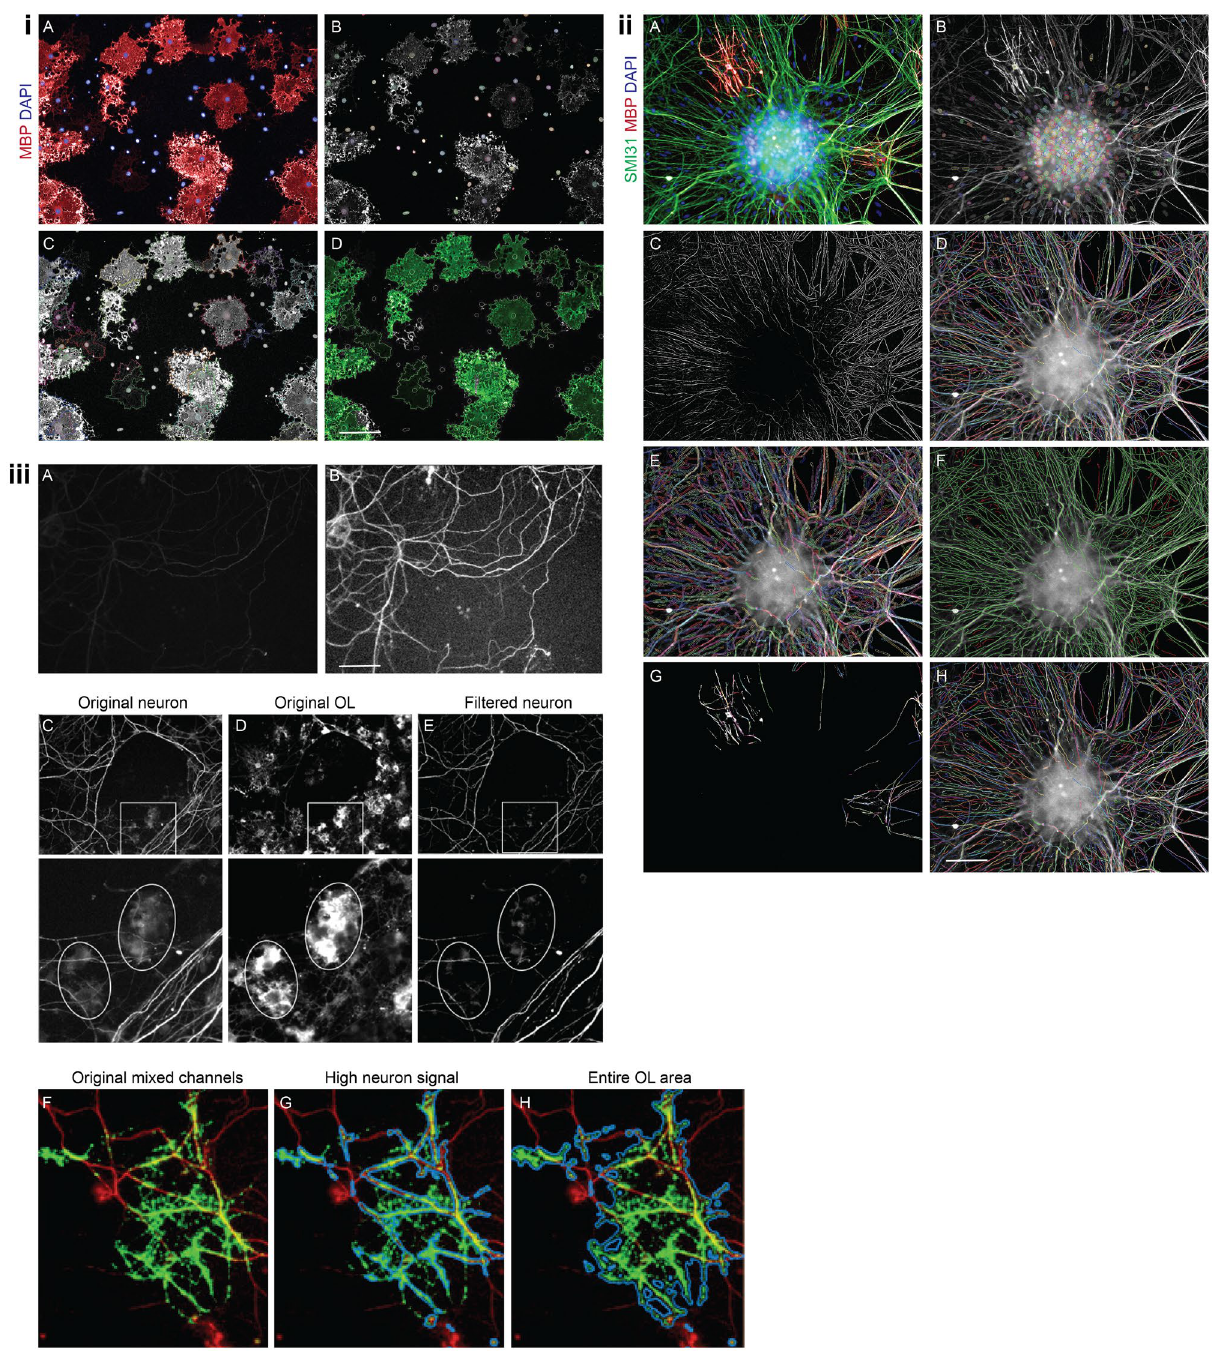
Figure 1. Representative images of OPC differentiation analysis sequence ( iA ) input data in step1, ( iB ) nuclei detection in step 2, ( iC ) cell cytoplasm detection in step 3, ( iD ) MBP+ population after definition of filter and characteristics properties in step 6. Representative images of length of myelinated segments calculation ( iiA ) input data in step 1, ( iiB ) nuclei detection in step 2, ( iiC ) image filtered by SER Ridge filter using Kernel normalization in step 3, ( iiD ) defining neurite segments by CSIRO neurite analysis in step 4, ( iiE ) background definition of neurite segment population in step 5, ( iiF ) axon selection from neurite segment population in step 10, ( iiG ) myelinated axon definition from axon population by Dyelight threshold settings in step 11, ( iiH ) unmyelinated axon definition in step 12. Representative images of myelin index calculation of RGC-OPC co-cultures ( iiiA ) raw neuron image and ( iiiB ) neuron image after contrast stretch in step 3, cleaning leak between channels ( iiiC ) original neuron ( iiiD ) original OL and ( iiiE ) filtered neuron in step 4, detection of OL area from ( iiiF ) original mixed channels the ratio of ( iiiG ) high neuron signal, calculated in step 6 and ( iiiH ) each entire OL area, calculated in step 5 represents the myelination index in step